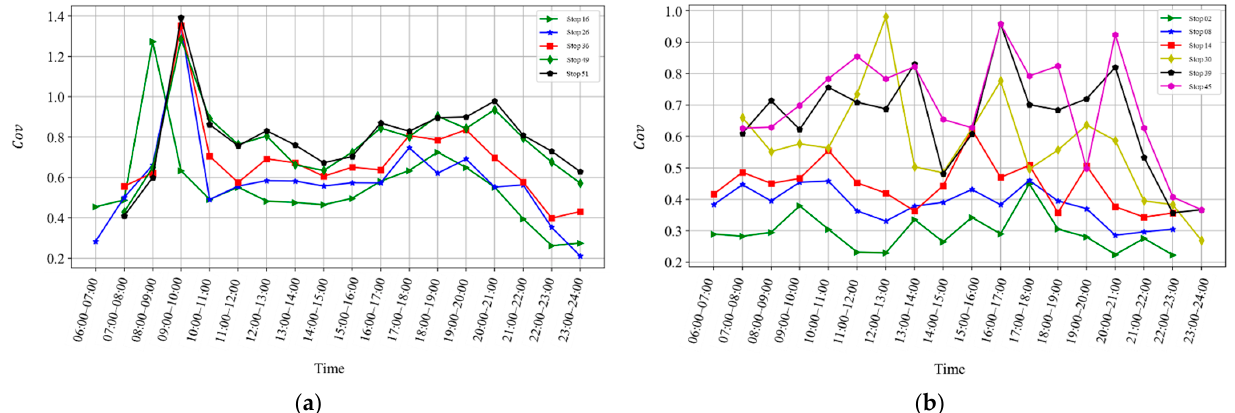
Figure 9. The 𝐶𝑜𝑣 at different bus stops on a work day and non-work day: ( a ) On a work day; ( b ) On a non-work day.